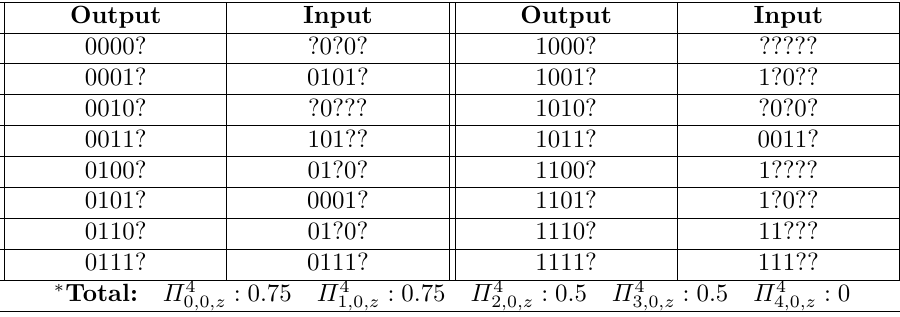
Table 3: Recovered bits under different